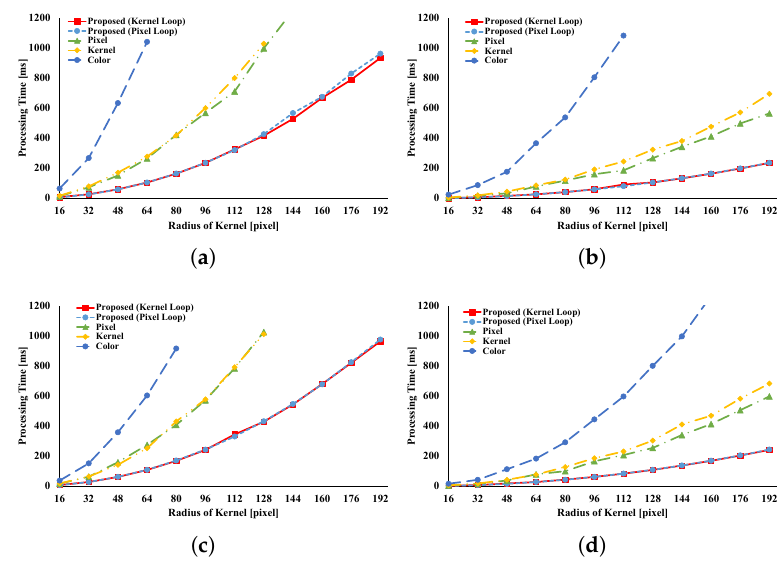
Figure 14. Processing time for randomly-kernel-subsampled Gaussian range filtering (RKS-GRF) with respect to the kernel radius of FIR filtering. ( a ) 1/4 subsample in weight computation; ( b ) 1/16 subsample in weight computation; ( c ) 1/4 subsample in LUT; ( d ) 1/16 subsample in LUT. Arbitrary pixel loop unrolling and arbitrary kernel loop unrolling are used in the place of pixel loop unrolling and kernel loop unrolling, respectively.